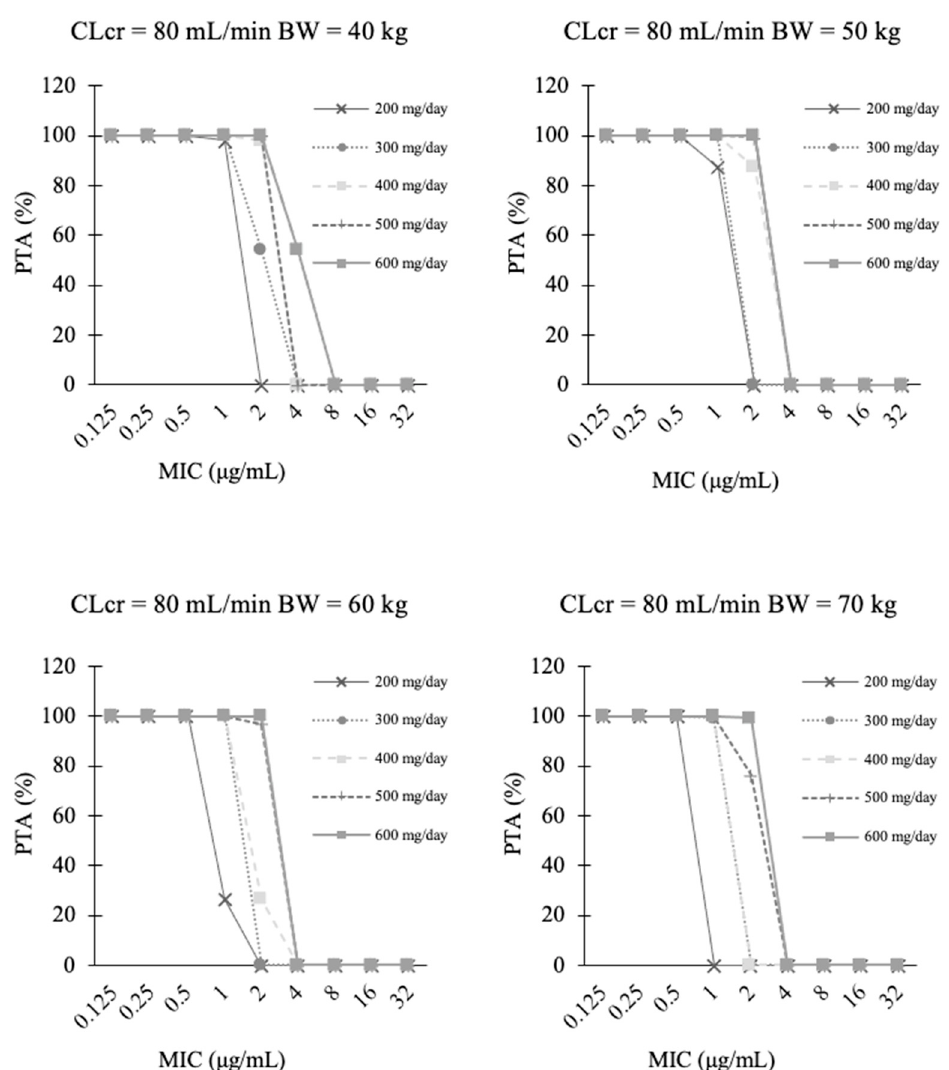
Figure 3. Probability of target attainment (PTA) of f AUC/MIC ratio ≥ 50 after fluconazole loading doses of 200 mg, 300 mg, 400 mg, 500 mg, and 600 mg administered on Day 1 (0–24 h). The target MIC was 2 μ g/mL, and the CLcr (Cockcroft-Gault equation) was 80 mL/min. The other CLcr is shown in Figure S1.